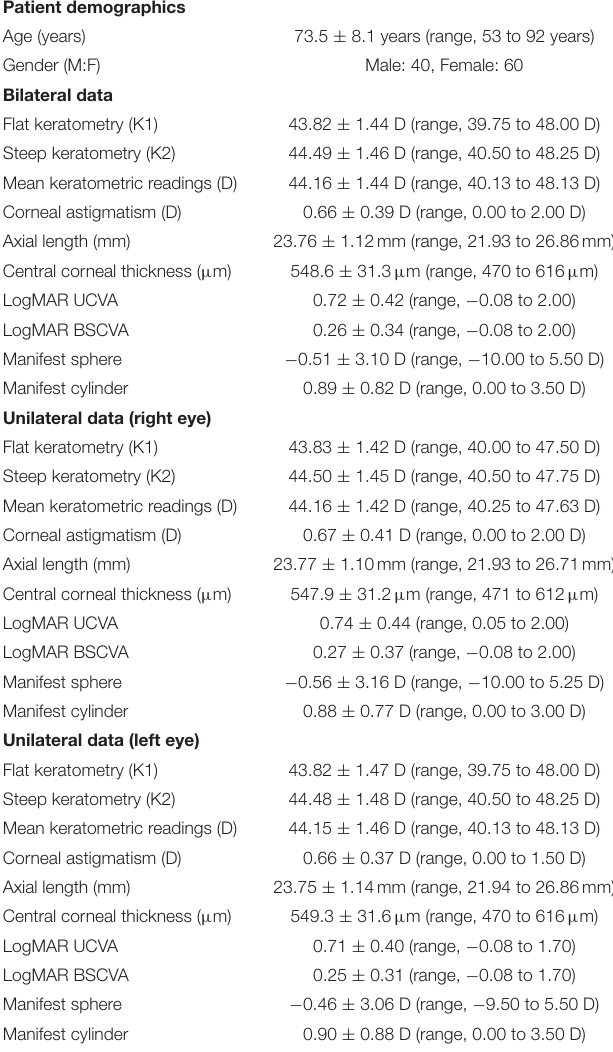
TABLE 1 | Preoperative demographic data of the study population through a 2.8mm temporal clear corneal